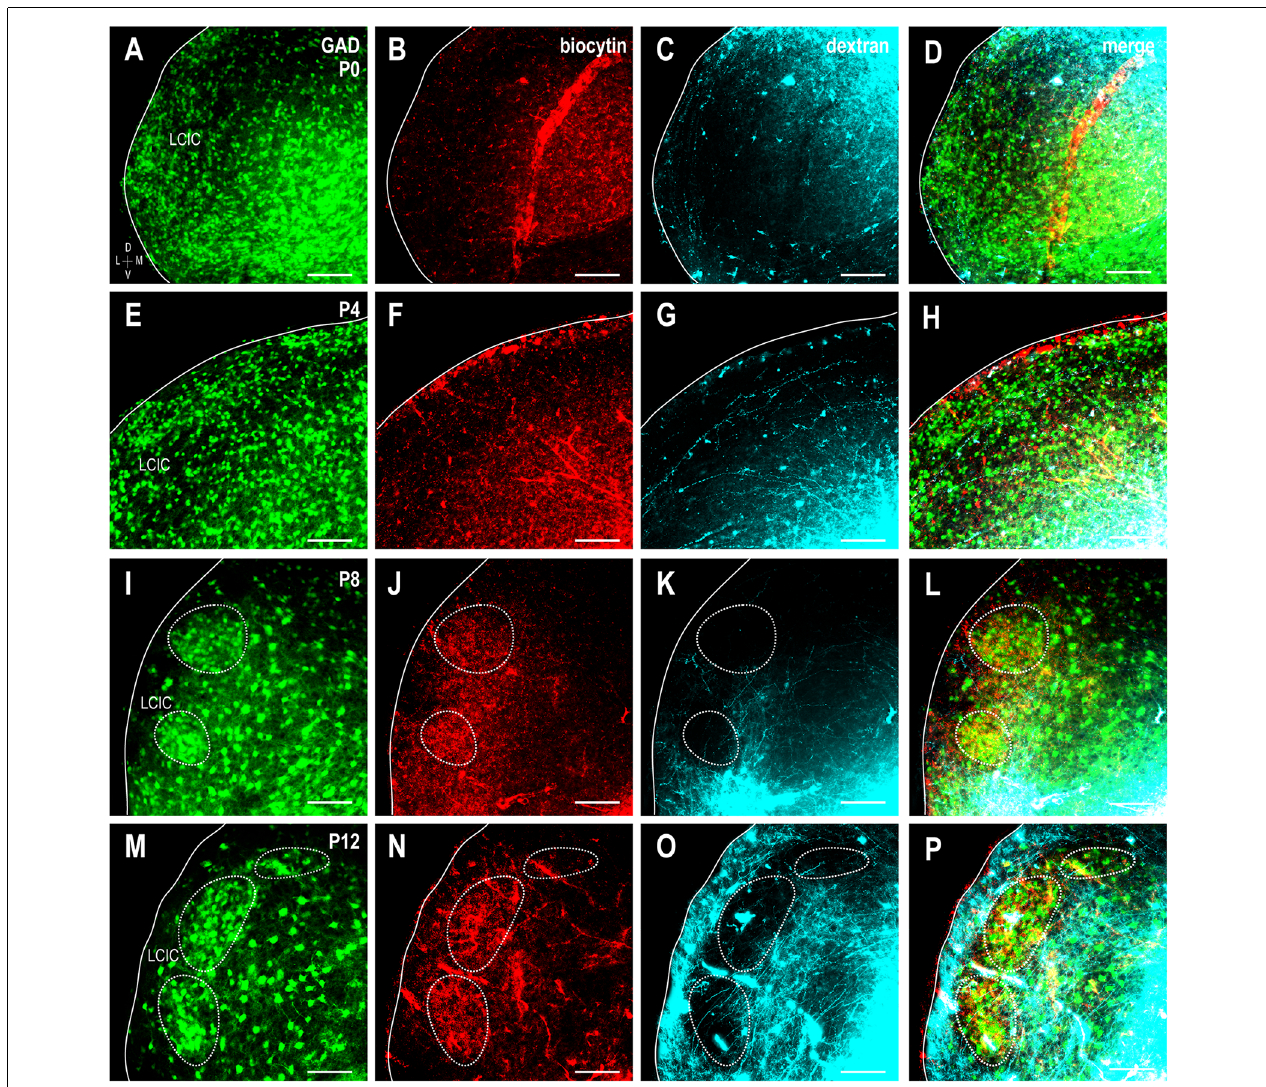
FIGURE 8 | Shaping of somatosensory corticocollicular (red) and auditory CNIC (cyan) inputs with respect to emerging LCIC modularity (green). Developmental progression shown for stages P0 (A–D) , P4 (E–H) , P8 (I–L) , and P12 (M–P) . Projections are unorganized at birth and often remain so at P4 as LCIC compartments are just emerging. By P8, GFP-positive modules are evident (dashed contours) as somatosensory and auditory terminals appear to separate. Adult-like, fully segregated multisensory afferent patterns are reliably observed at P12. Scale bars = 100 µ